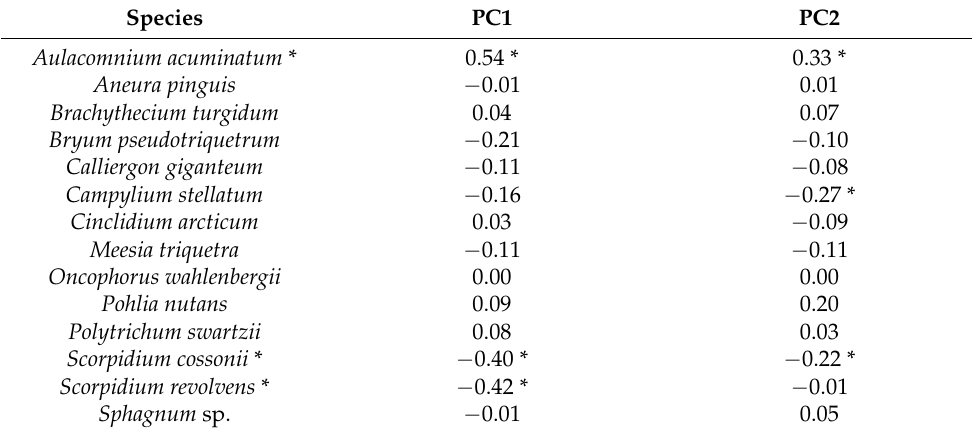
Table A3. Contribution loading of each species analyzed by principal component analysis (PCA). Only the first two axes are shown. Species with the highest loadings on either side of each axis are indicated with an asterisk